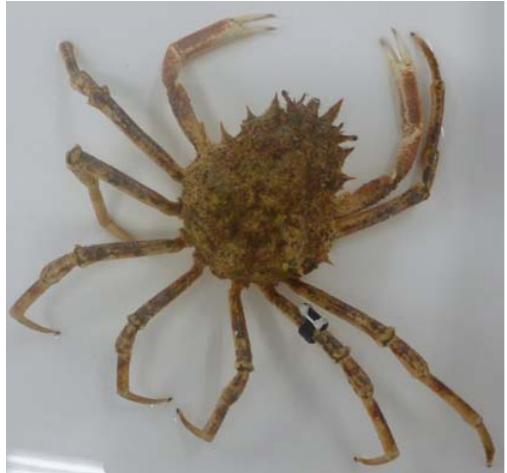
Figure 5. Maja 1 equipped by a V13TP VEMCO